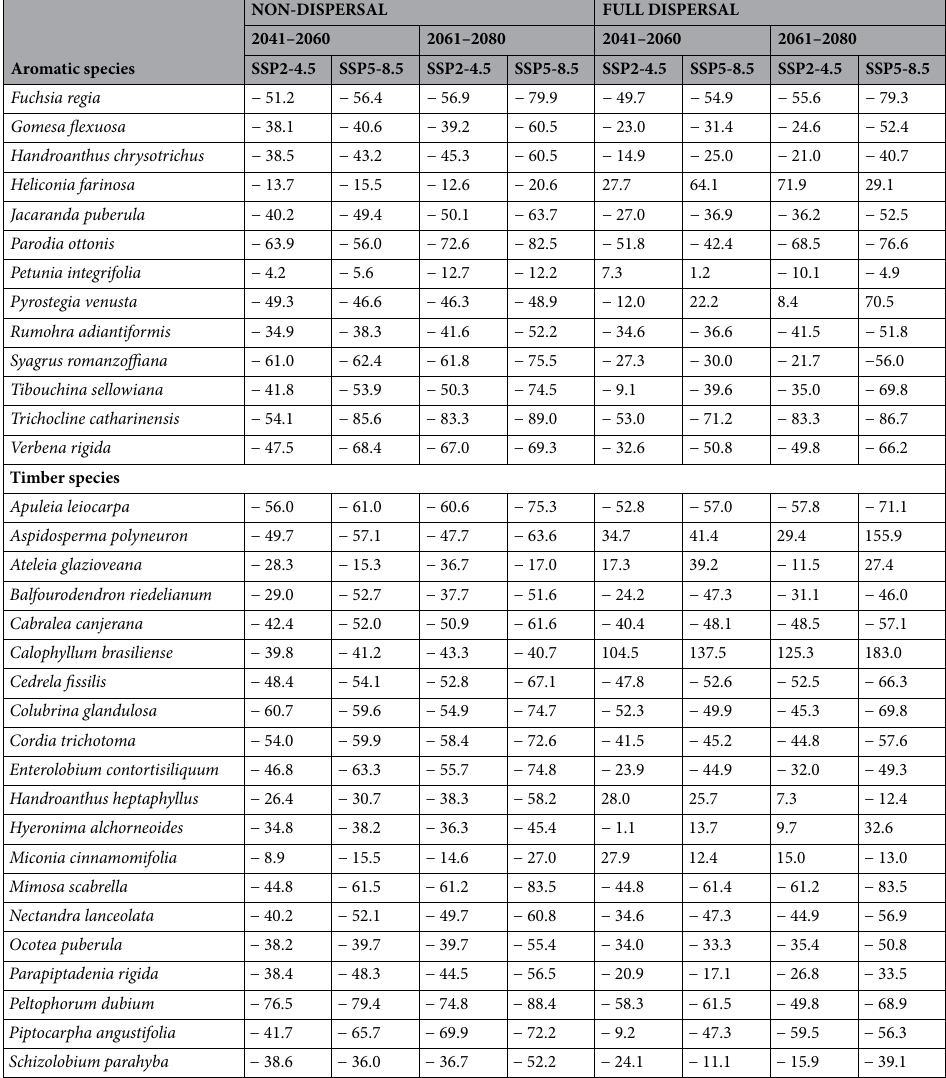
Table 1. Future range changes for 135 native potential agroforestry plant species in Brazil under two dispersal